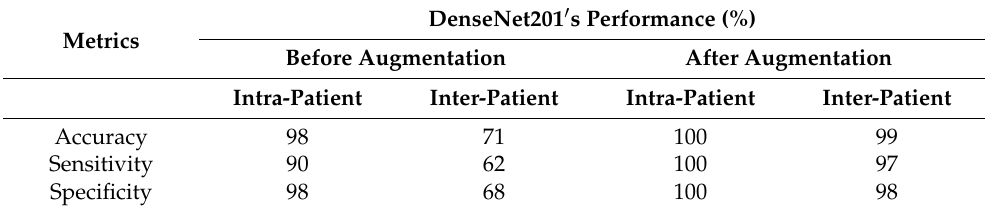
Table 6. Eight-class classification average performance after data augmentation.